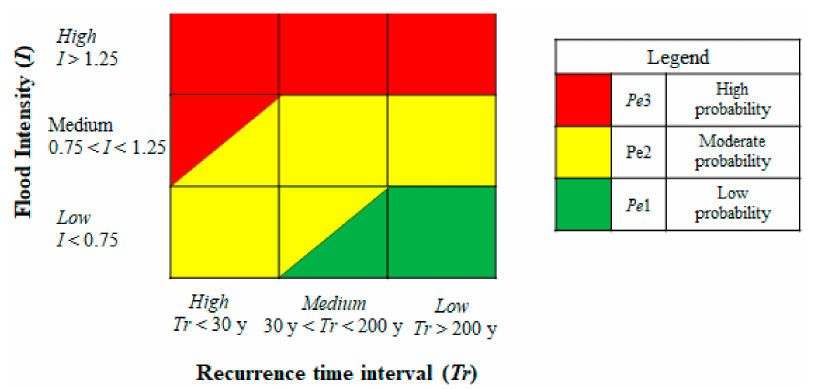
Figure 2. Flood hazard